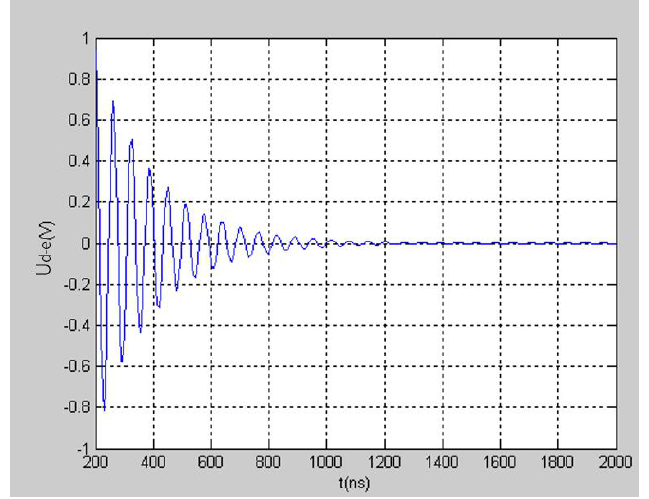
Figure 6. Simulation waveform of coupling network.